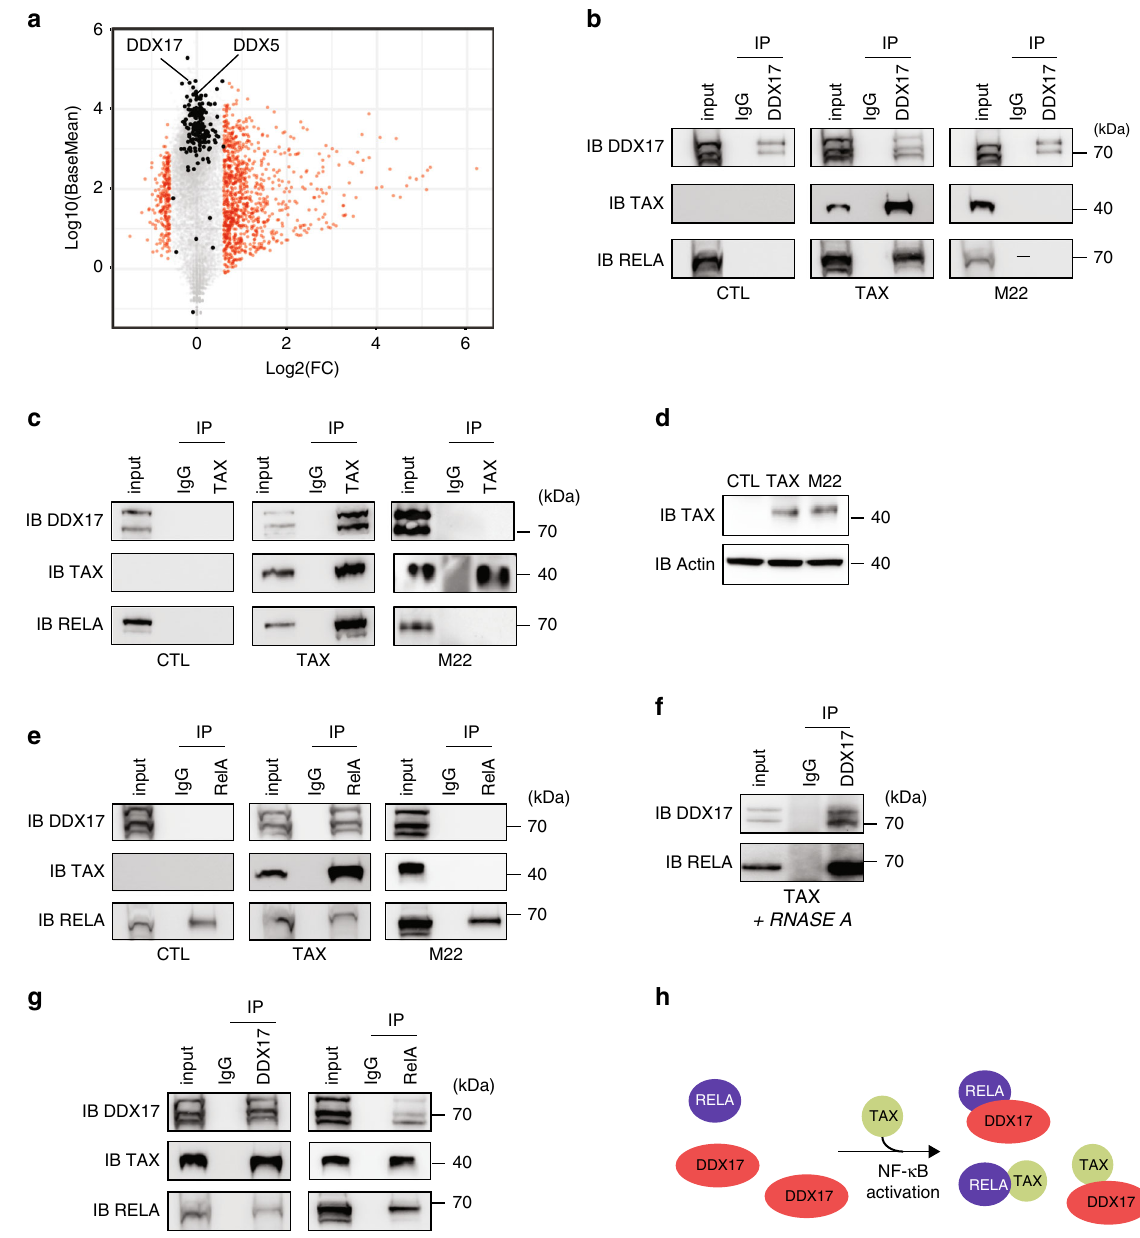
Fig. 2 Physical interactions between Tax, RELA, and DDX17 in an NF-kB dependent manner. a Mean average plot ( n = 3, p < 0.05) of cellular gene expressions upon Tax. Each gene is plotted according to its expression level (log10(BaseMean) from DESeq2 analysis) and to fold change (log2-FC) upon Tax. Red dots show signi fi cant gene expression changes in HEK cells (log2-FC > 0.6, p < 0.05, Fisher ’ s exact test). Black dots highlight genes encoding splicing factors. DDX5 and DDX17 are indicated. b Immunoprecipitation assays (IP) were carried out in HEK cells using isotype IgG or anti-DDX17 ( b , g ), anti-RELA ( e , g ), and anti-Tax ( c , g ) antibodies, followed by immunoblotting (IB) with indicated antibodies. d Western blot analysis of Tax and M22 expression 48-h post-transfection. f RNA-free IP assays. g TNFa exposure of M22-expressing cells promotes RELA – DDX17 interactions. h Model of NF- κ B- dependent interplay between Tax, RELA, and DDX17. For b – g , a representative image from three independent experiments is shown. Source data are provided as a Source Data fi